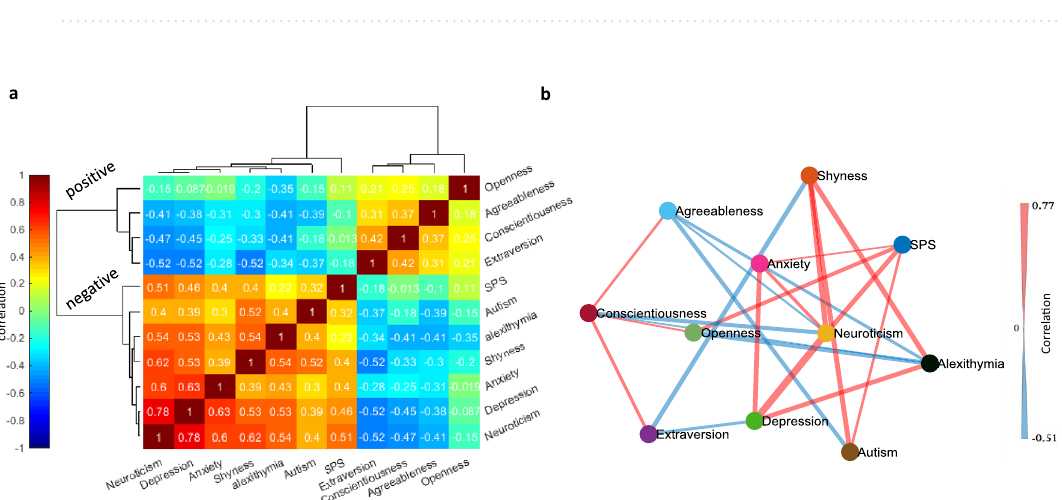
Figure 2. Pairwise correlation and graph representation of traits based on partial correlations. ( a ) Color-coded pairwise correlation matrix of 11 traits sorted by unsupervised HC. ( b ) The weighted undirected graph of 11 categories as extracted by the PC-stable algorithm. Color-coded edges surviving partial correlation ( p < 0.01) are shown (red and blue indicating positive and negative correlations, respectively) and edge widths indicating the magnitude of partial correlation. Node locations are arranged by 2D embedding using